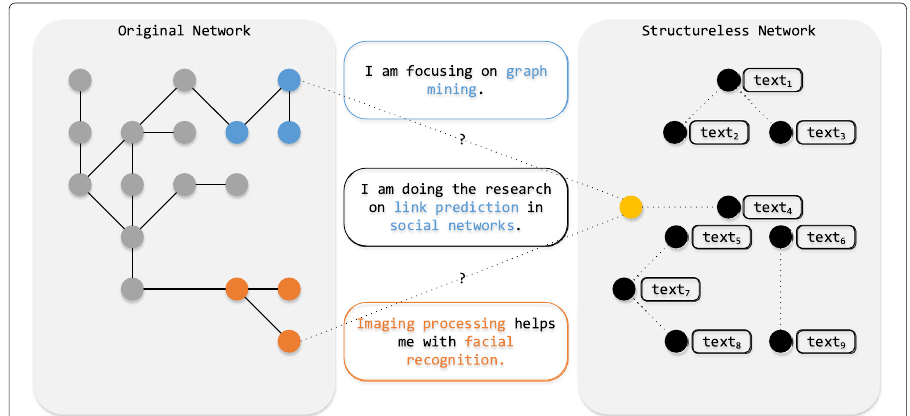
Fig. 1 Illustration of using text data to construct social relations. Color blue represents the topic of “network analysis,” while color orange represents the topic of “image processing.” The gray nodes consist of parts of the graph-structured data. The black nodes are in the structureless node set. The solid lines denote the existing links, while the dotted lines denote the potential links